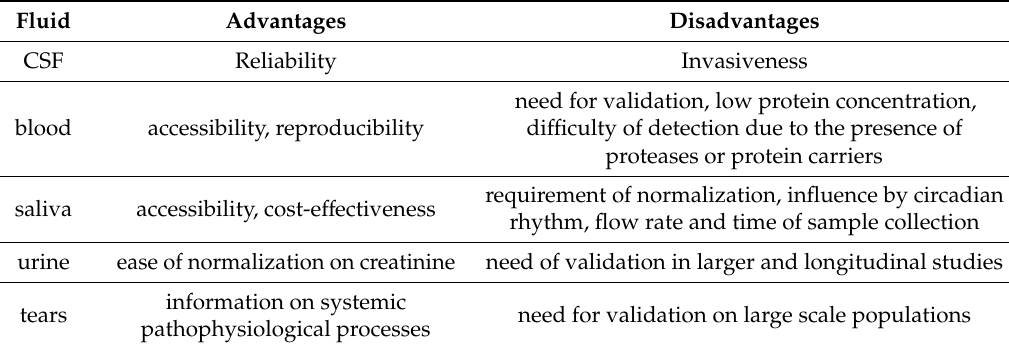
Table 6. Main advantages and disadvantages of biological fluid biomarkers for Alzheimer’s disease. Fluid Advantages Disadvantages CSF Reliability Invasiveness need for validation, low protein concentration, blood accessibility, reproducibility di ffi culty of detection due to the presence of proteases or protein carriers requirement of normalization, influence by circadian saliva accessibility, cost-e ff ectiveness rhythm, flow rate and time of sample collection urine ease of normalization on creatinine need of validation in larger and longitudinal studies information on systemic tears need for validation on large scale pathophysiological processes